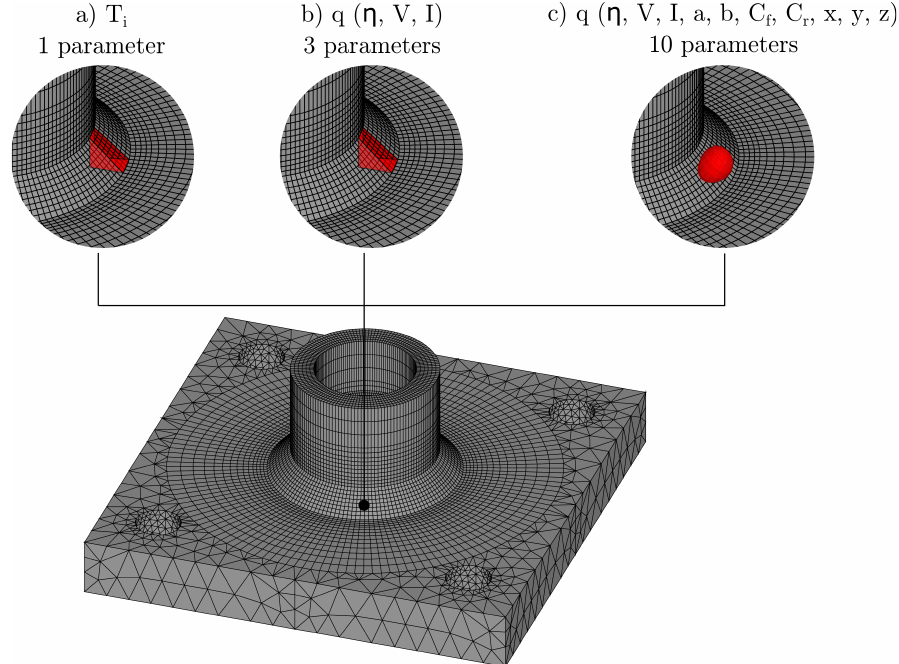
Figure 3. Meshed specimen (bottom) and simulation techniques applied on the welding seam: constant initial temperature ( a ), constant heat flux ( b ), and Goldak’s double-ellipsoid model ( c